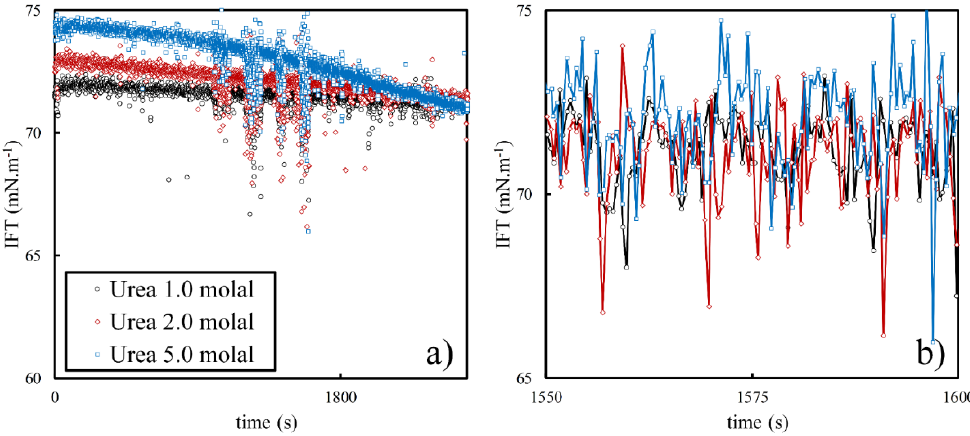
Figure 5. ( a ) Interfacial tension of urea solutions of 1.0, 2.0, and 5.0 molal while imposing area oscillations of different amplitudes; ( b ) zoomed-in view on one oscillation from ( a ) with the frequency of 0.1 Hz and the amplitude of 17%; the solid lines are drawn as a guide for the eye.